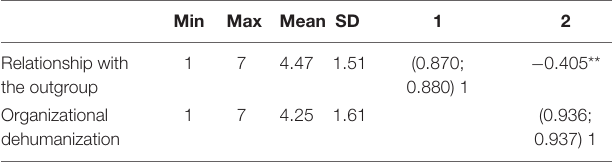
of the total sample.